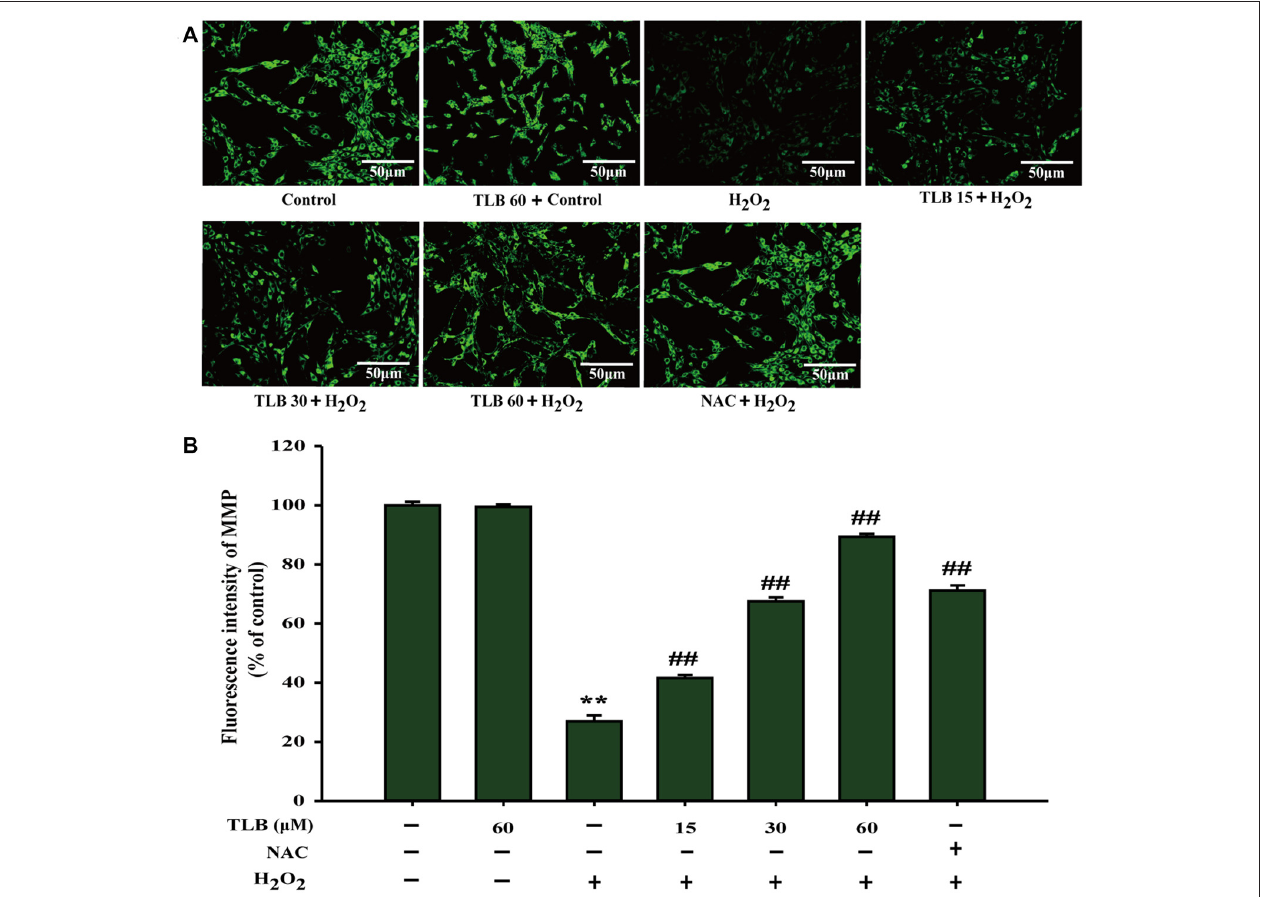
FIGURE 2 | TLB mitigated H 2 O 2 -induced collapse of mitochondrial membrane potential (MMP) in PC12 cells. After pre-treatment with or without TLB for 1 h, cells were treated with 400 µ M H 2 O 2 for another 48 h. (A) MMP was determined by the rhodamine 123. Magnification, 200 × ; scale bar = 50 µ m. (B) The mean fluorescence intensity of MMP was quantified using Image Pro Plus software. Data were presented as mean ± standard deviation (SD) of three independent experiments. ∗∗ P < 0.01 vs. untreated control cells; ## P < 0.01 vs. H 2 O 2 -treated